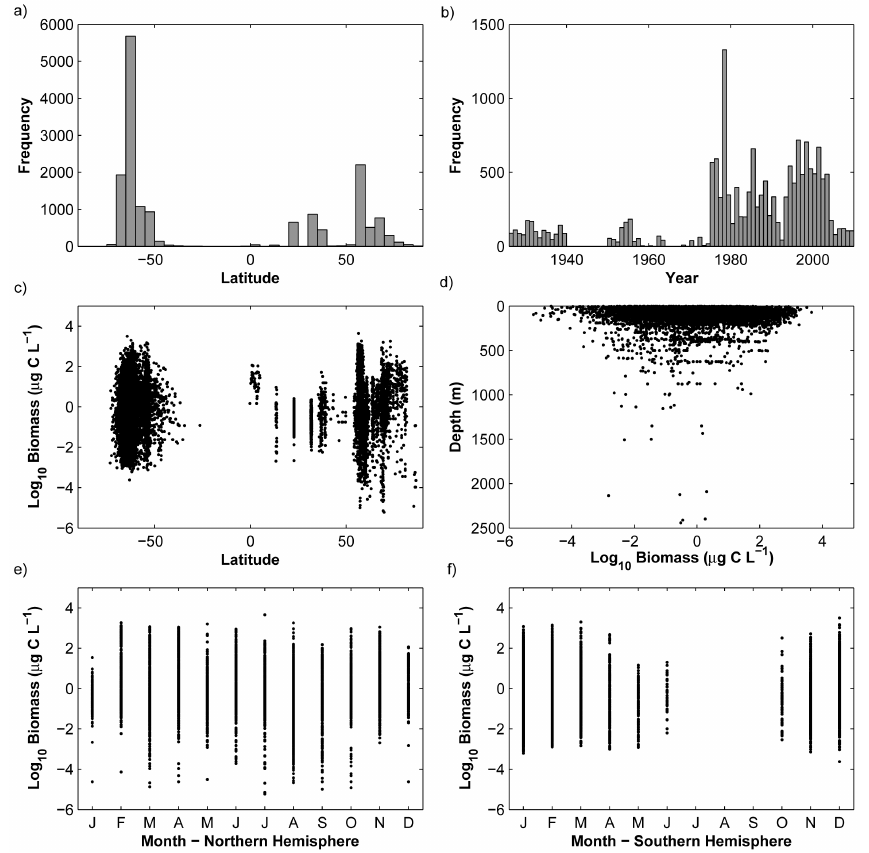
Figure 4. Description of macrozooplankton biomass: (a) latitudinal distribution of observations, (b) yearly distribution of observations, (c) latitudinal distribution of biomass, (d) depth distribution of biomass, (e) monthly biomass distribution in the Northern and (f) Southern Hemispheres. There are no data for biomass in the Southern Hemisphere winter months (July, August, September). Table 3a. Global and latitudinal band values for the gridded macrozooplankton abundance data. Abundance (ind. L − 1 ) Latitude n Min. Max. Mean Median ± std. Global 21293 9 . 19 × 10 − 9 5.11 0.018 0.0006 0.123 90–40 ◦ N 7216 1 . 00 × 10 − 8